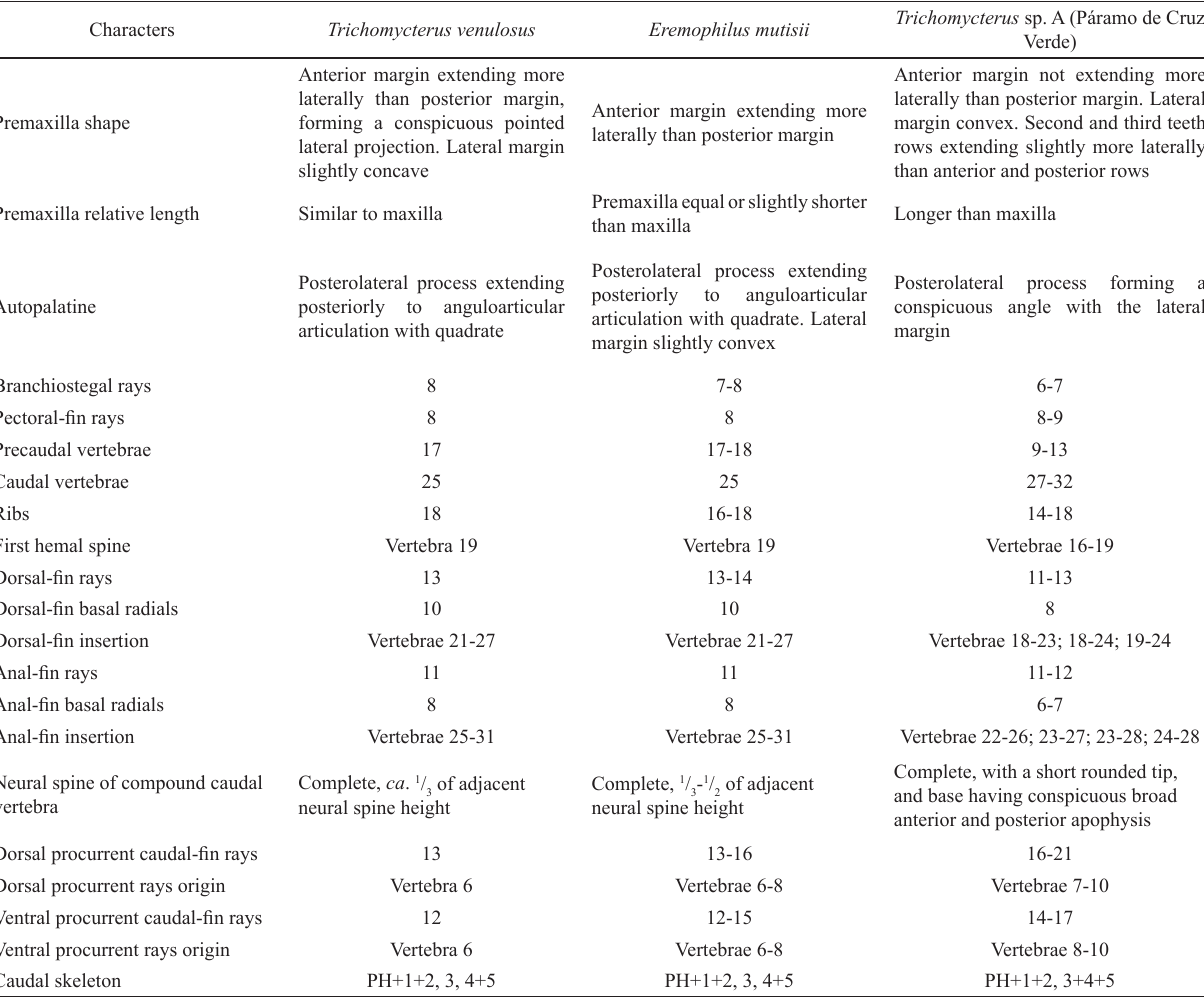
Table 1. Comparative list of osteological and meristic characters for Trichomycterus venulosus (NMW 44476: 1, syntype